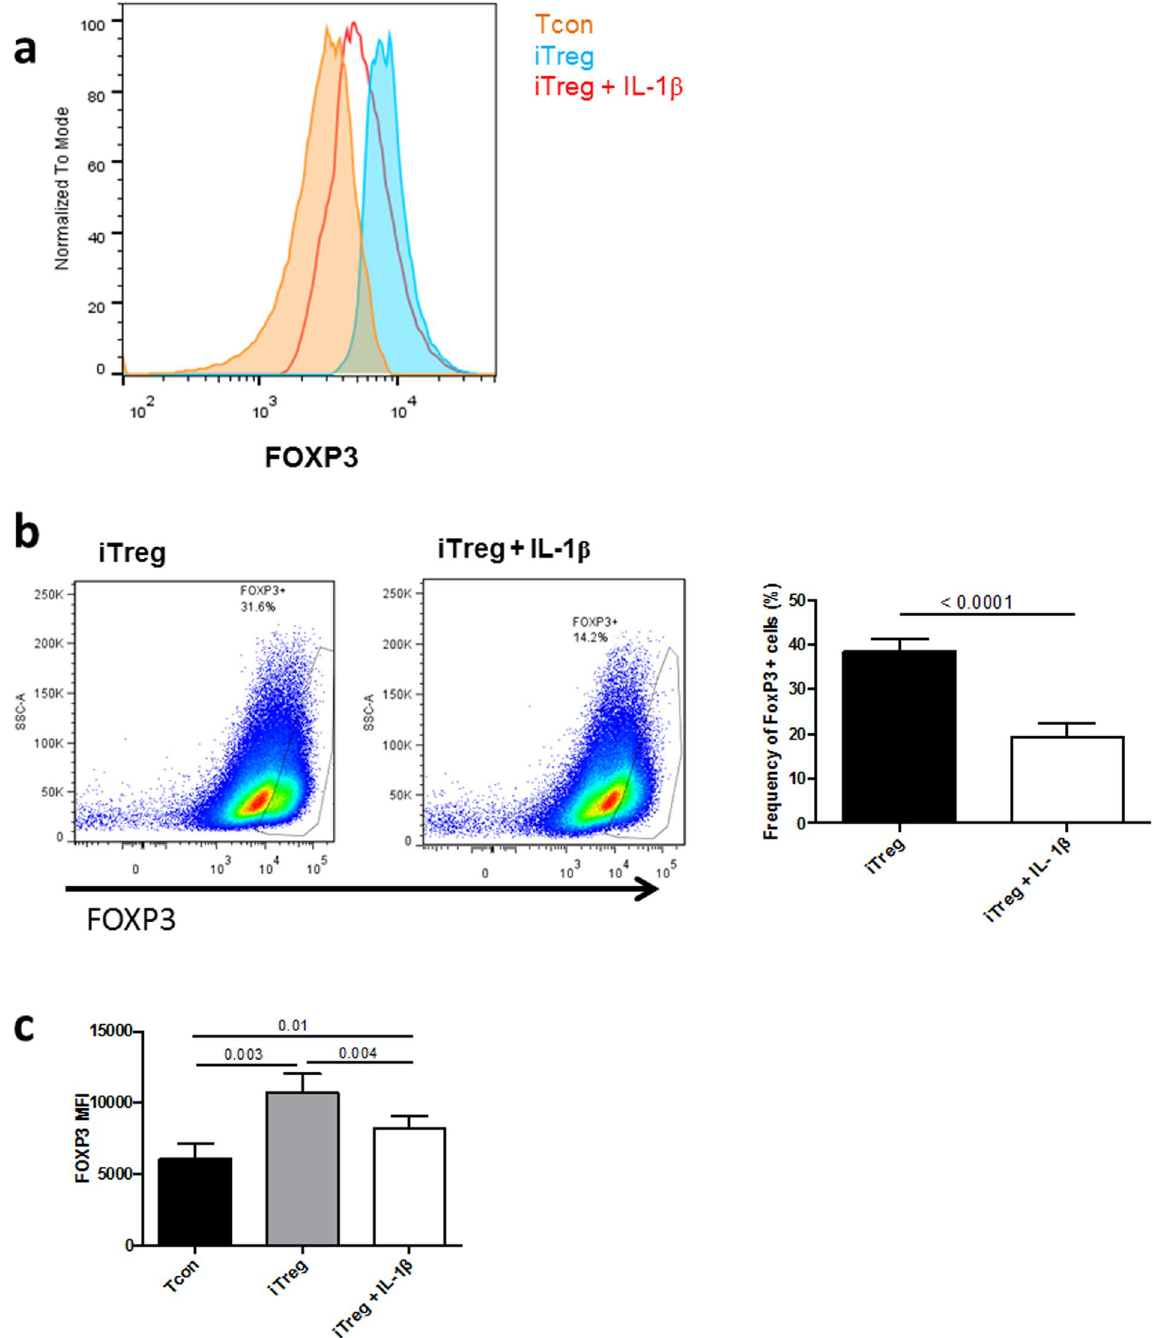
Figure 1. IL-1 β abrogates iTreg differentiation. ( a ) Representative flow cytometry histogram showing FOXP3 expression in CD4 + cells, cultured for 6 days in unpolarized conditions (Tcon) or Treg-skewing conditions (iTreg), in absence or presence of IL-1 β (100 ng/mL). ( b ) Left panel: representative FACS dot plots of FOXP3 + cells of CD4 + cells at d6 of iTreg polarization with and without IL-1 β stimulation. Right panel: mean ( ± SEM) percentage of FOXP3 + cells in iTreg cultured in presence or absence of IL-1 β (n = 12). Threshold of positivity was set according to unpolarized Tcon cells. ( c ) Mean ( ± SEM) FOXP3 MFI in iTreg cultured in presence or absence of IL-1 β (n = 12). P values correspond to paired